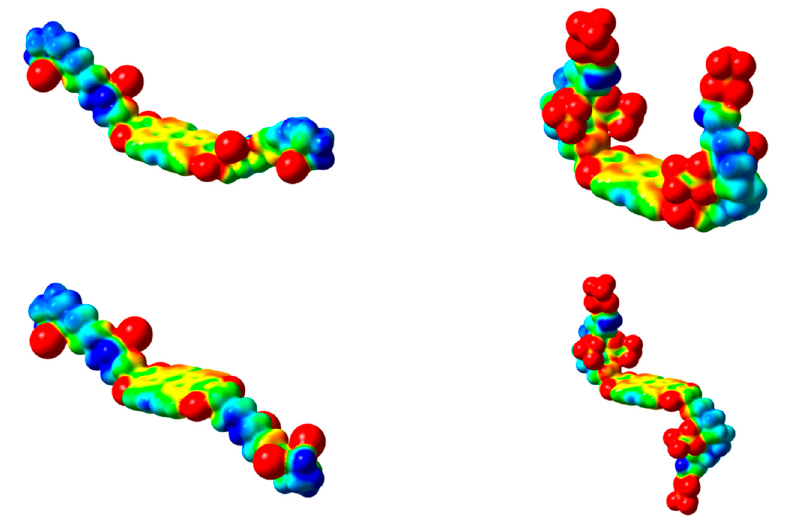
Figure 2. Electron density cloud for the hydrochloride 4 ( left ) and trifluoroacetate salt 5 ( right ) in CIS ( up ) and TRANS ( down ) dispositions of side chains.